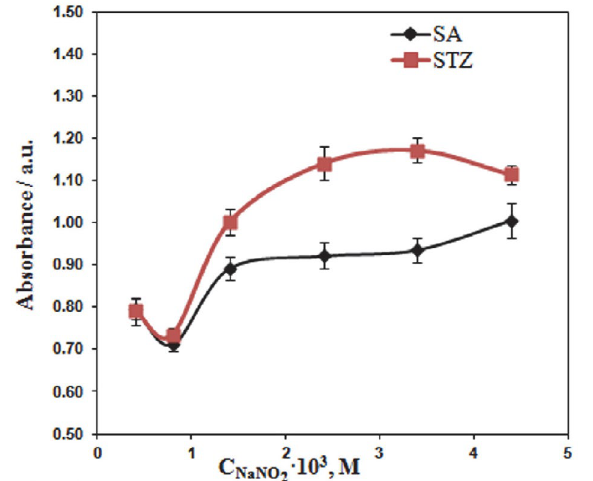
Fig. 3. Effect of sodium nitrite concentration during SA and STZ diazotization on and the SA and STZ interaction with AM. 1. C SA = 2.0 . 10 –4 M, C HCl = 0.6 M; 2. C STZ = 2.0 . 10 –4 M, C HCl = 0.7 M; C AM = 5.0 . 10 –5 M, C Na = 0.1 M, n = 2 B 4 O 7